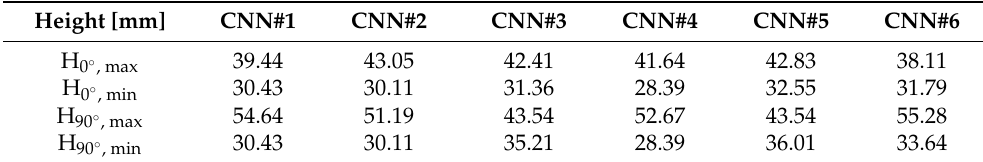
Table 3. Height features of the derived preform shapes for the symmetric forging.